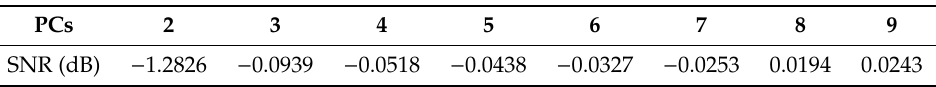
Table 6. The signal-to-noise ratio (SNR) of every principle components (PCs) with PCs1.